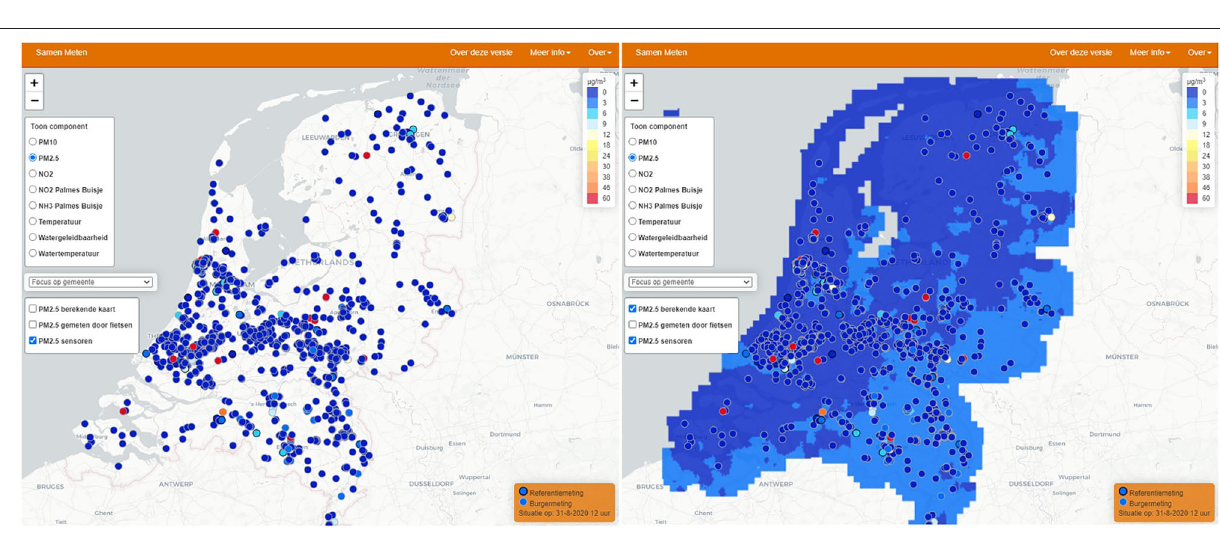
FIGURE 2 | Samen Meten data portal showing the density of the PM2.5 sensor locations and reference stations (A) on the map of the Netherlands, and the same against a backdrop of air quality model results (B) . Colors are an indication of the height of the PM2.5